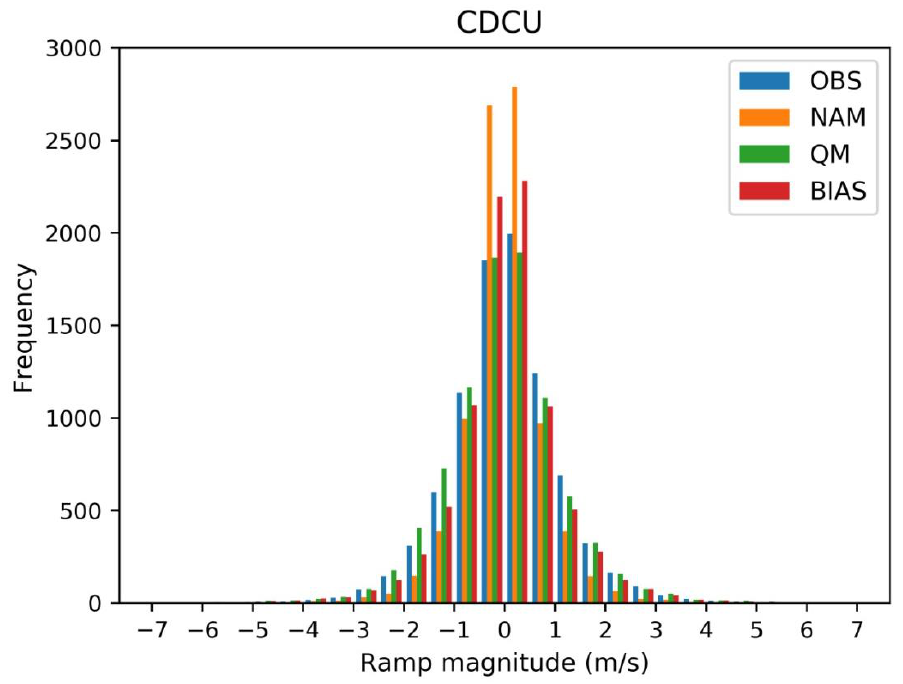
Figure 7. Wind-ramp distribution for CDCU observations (blue bar), NAM (orange bar), Quantile mapping correction (QM) (green bar) and Simple bias correction (red bar).